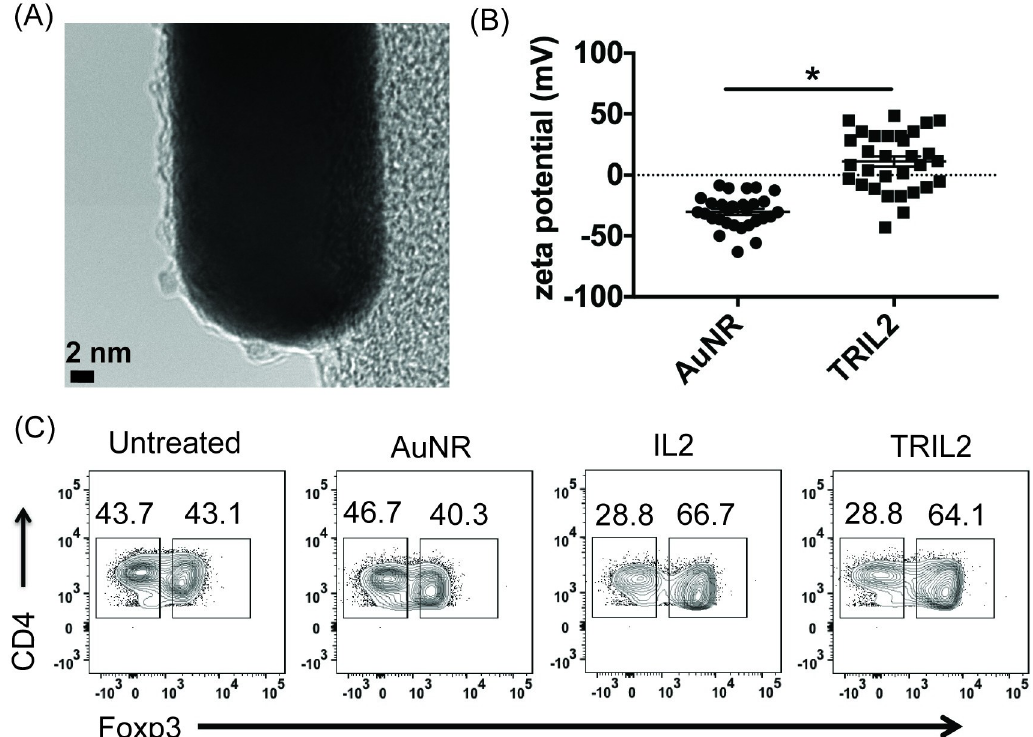
Fig 4. AuNRs functionalized with IL2 enhance CD4+ Foxp3+ Tregs. (A) TEM image of AuNRs conjugated to IL2 (TRIL2). (B) Zeta potential of AuNR and TRIL2. (C) Magnetically isolated CD25+ splenocytes treated with 5 μ g/ml of either AuNR, IL2, or TRIL2. The flow data are gated on the percent live, and the data shown is a compilation of 3 independent experiments; n = 9 per group. The data is represented as scatter dot plots, where error bars represent the standard error of the mean and � p � 0.05 is significant as determined by a two-sided t